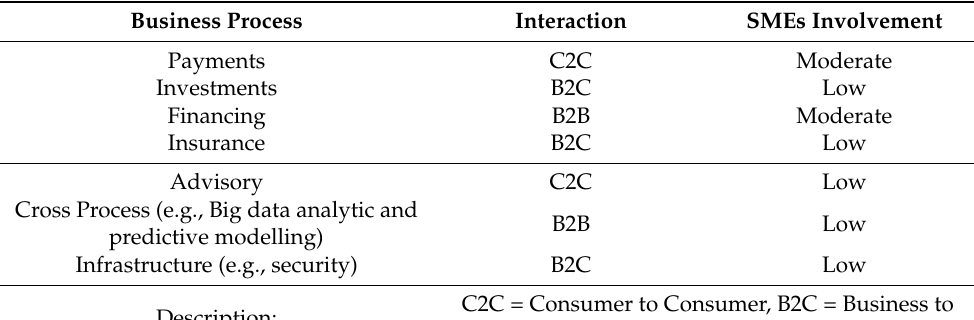
Table 7. Illustration of the use of fintech in SMEs business processes in